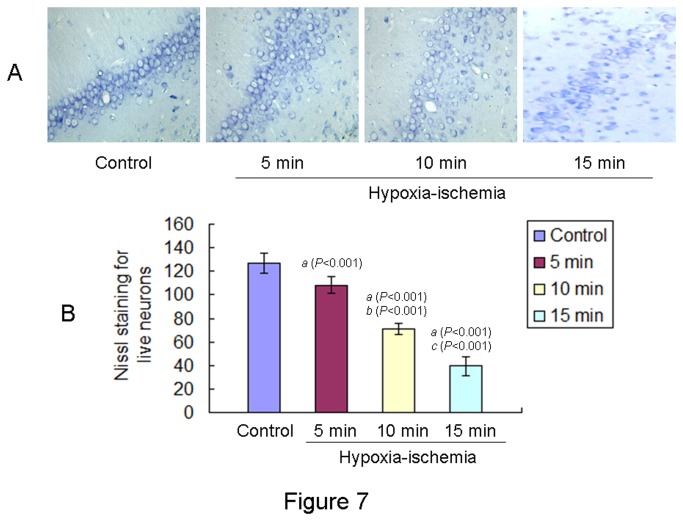
Nissl staining showed neuronal cells in the hippocampus of offspring rats from different groups.
A: Representative histological sections of Nissl staining of neurons in the hippocampus (CA1) of neonatal rat brains from different groups were showed (scale bar: 400μm).
B: Total Nissl-positive neuronal cells were calculated in six randomly chosen views. Total Nissl-positive neuronal cells per view in the hippocampus (CA1) of offspring rats from different groups (n= 12 in each group) at PND 35 were showed. The results were expressed as mean ± S.D.. a: compared with the control group; b: compared with the 5 min HIE group; c: compared with the 10 min HIE group. All P values were <0.001.